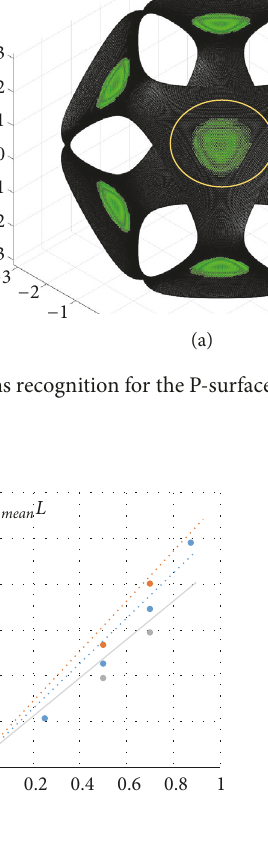
are represented with green dots in the case of a P-surface obtained setting k = -0.7 and s = 1 in (1).